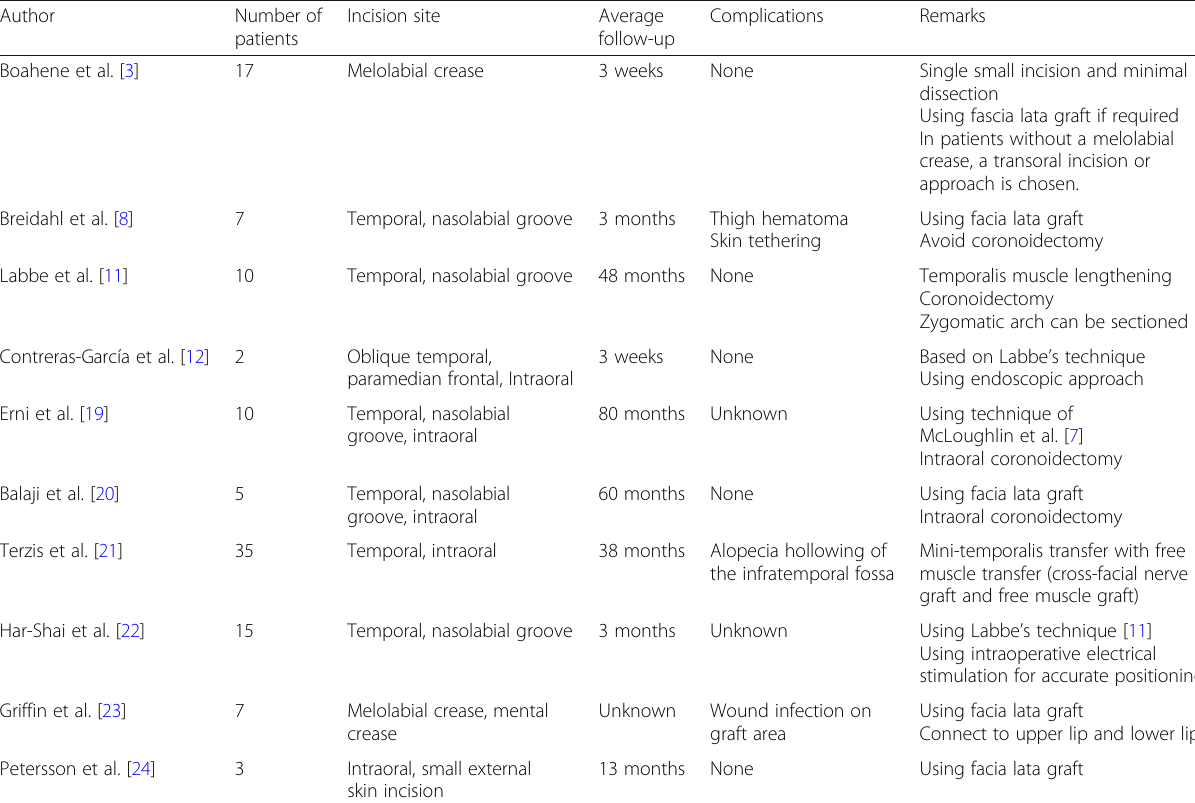
Table 1 Surgical techniques of previously reported temporalis tendon